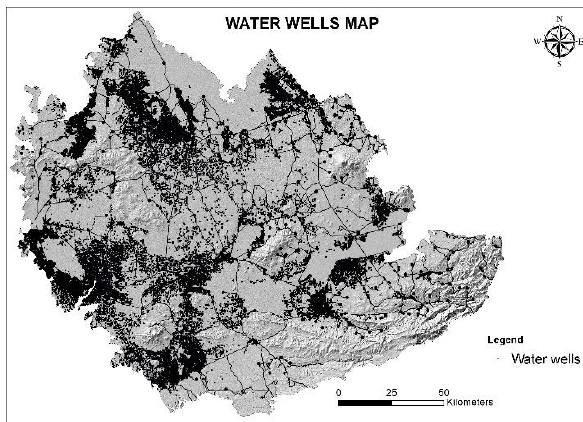
Figure 2. Water wells in study